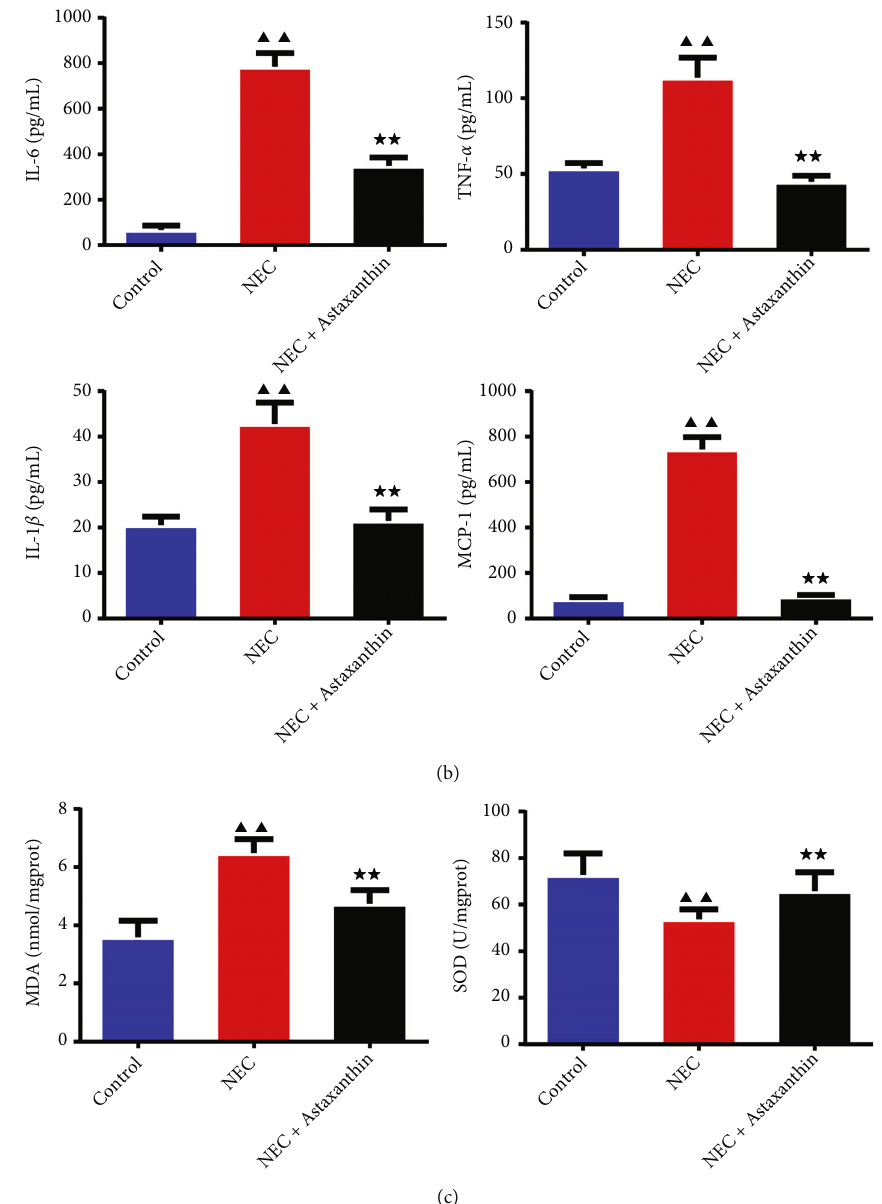
Figure 1: Astaxanthin alleviated the pathological change and restrained the in fl ammatory and oxidative stress cytokines of the intestinal tissue in necrotizing enterocolitis (NEC) rats. (a) The histomorphology in intestinal tissues in rats was observed by hematoxylin-eosin (HE) staining (magni fi cation × 200, 400), and the HE scores were calculated in each group, n = 6 in each group. (b) The serum content of interleukin-1 beta (IL-1 β ), interleukin 6 (IL-6), tumor necrosis factor- α (TNF- α ), and macrophage chemoattractant protein-1(MCP-1) were tested by enzyme-linked immunosorbent assay (ELISA) kit, n = 6 in each group. (c) The content of malondialdehyde (MDA) and superoxide dismutase (SOD) in intestinal tissue was tested by the ELISA kits. n = 6 in each group. ▲▲ P < 0 : 01 vs. control group. ★★ P < 0 : 01 vs. NEC